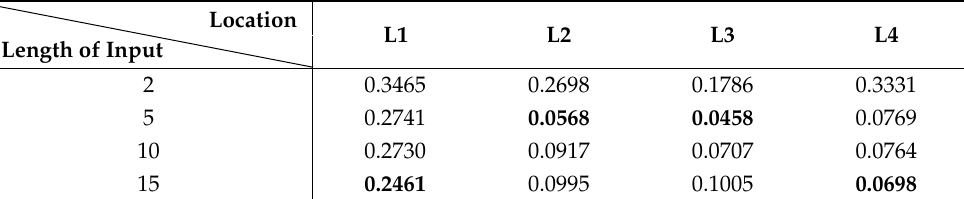
Table 1. RMSE ( ◦ C) variation of different input lengths at different positions, where the bold font is the minimum value of each column.